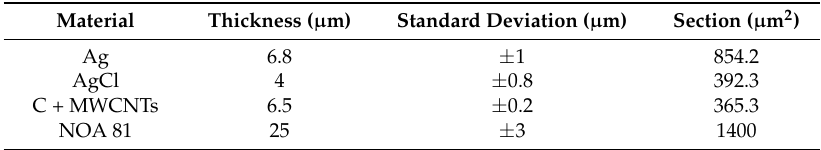
Table 2. Thickness and sections of deposited inks.